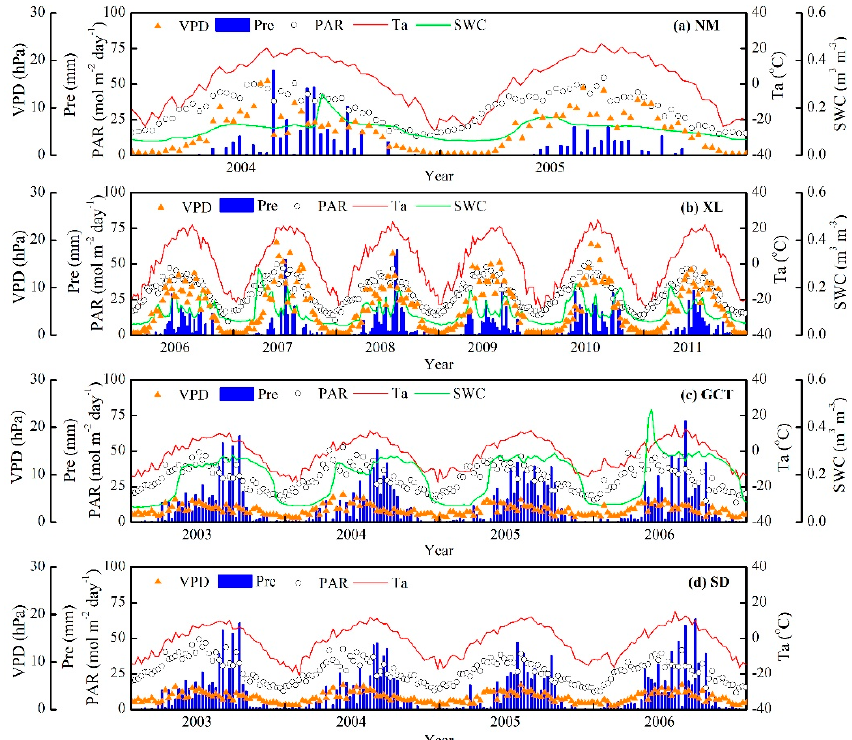
Figure 4. Seasonal and interannual variations in precipitation (Pre), air temperature (Ta), vapor pressure deficit (VPD), photosynthetically active radiation (PAR), and soil water content (SWC) at the (a) NM, (b) XL, (c) GCT, and (d) SD flux tower sites. SWC was measured at depths of 0–20 cm at the NM and GCT sites and 0–10 cm at the XL site. SWC was not measured at the SD site due to the waterlogged soil surface.